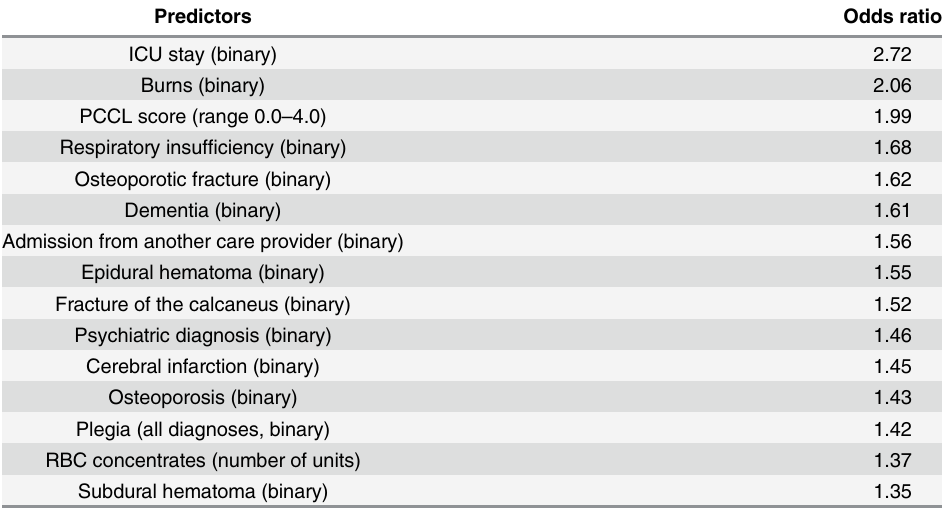
Table 2. 15 most important predictors derived from the L1 regularized logistic regression analysis (LASSO) for deficit outliers determined by IQR method. Predictors were ordered by the magnitude of their odds ratio (n = 20,000, training set).